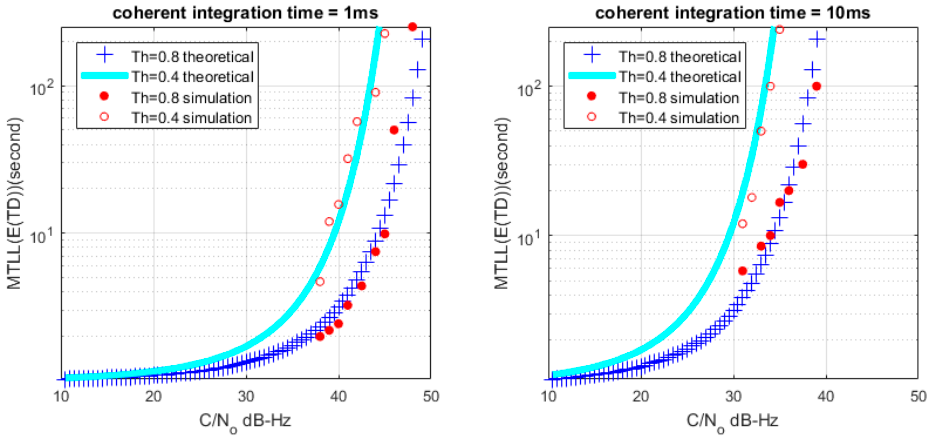
Sensors 2017 , 17 , 2808 Figure 9. Relation between MTLL ( { } Figure 9. Relation between MTLL ( E { T D } ) and C / N 0 ( M = 20) under signal presented situation.